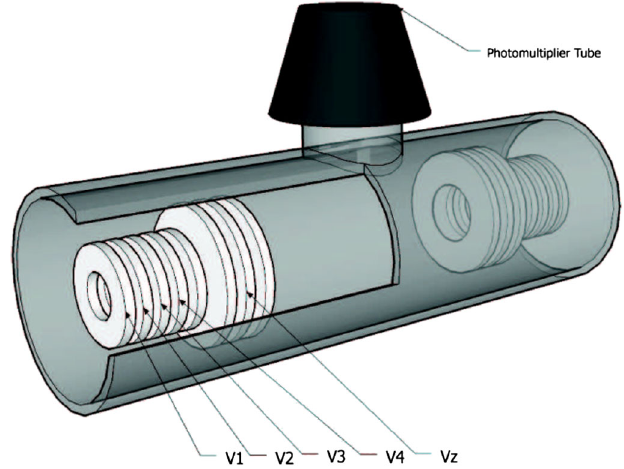
FIG. 1. Overview of the EIBT. Five potentials are applied to the electrodes, the other are grounded. The injection of the bunch of ions is performed when all the electrodes on one side of the trap are grounded. The potentials are raised before the bunch has time to come back. This trap can be used to make metastable state lifetime measurements, hence the photomultiplier